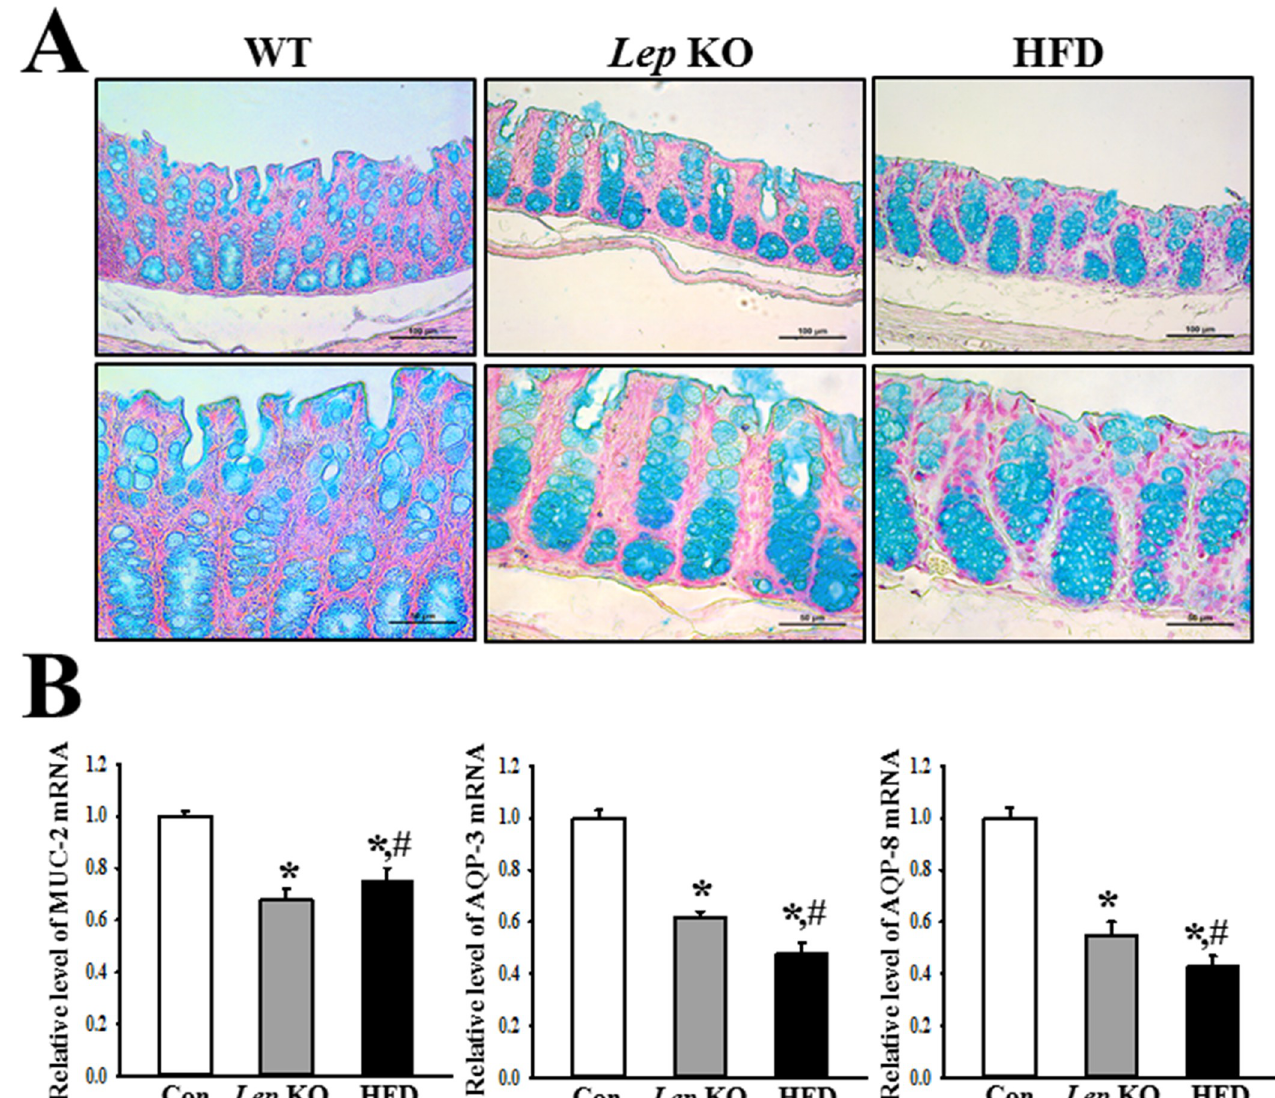
Fig 5. Level of mucin secretion and water channel expression. (A) Level of mucin secretion. Mucin in the mid colon section was stained with alcian blue at pH 2.5. Their images were observed at 400 × magnification. Five to six mice per group were used in the slide section, and mucin staining was assessed in duplicate in two different slides. (B) Levels of MUC2, AQP3, and AQP8 expression. The mRNA levels of the three genes were calculated based on the transcript level of β -actin as an endogenous control. Three to five mices per group were used to prepare the total RNA, and RT-qPCR analyses were assayed in duplicate for each sample. The data are reported as the mean ± SD. � indicates p < 0.05 compared to the Con group. Abbreviations: Con, Control group; Lep KO, Leptin knockout mice; HFD, High fat diet; RT-qPCR, Quantitative real time-PCR; MUC2, Mucin 2; AQP,